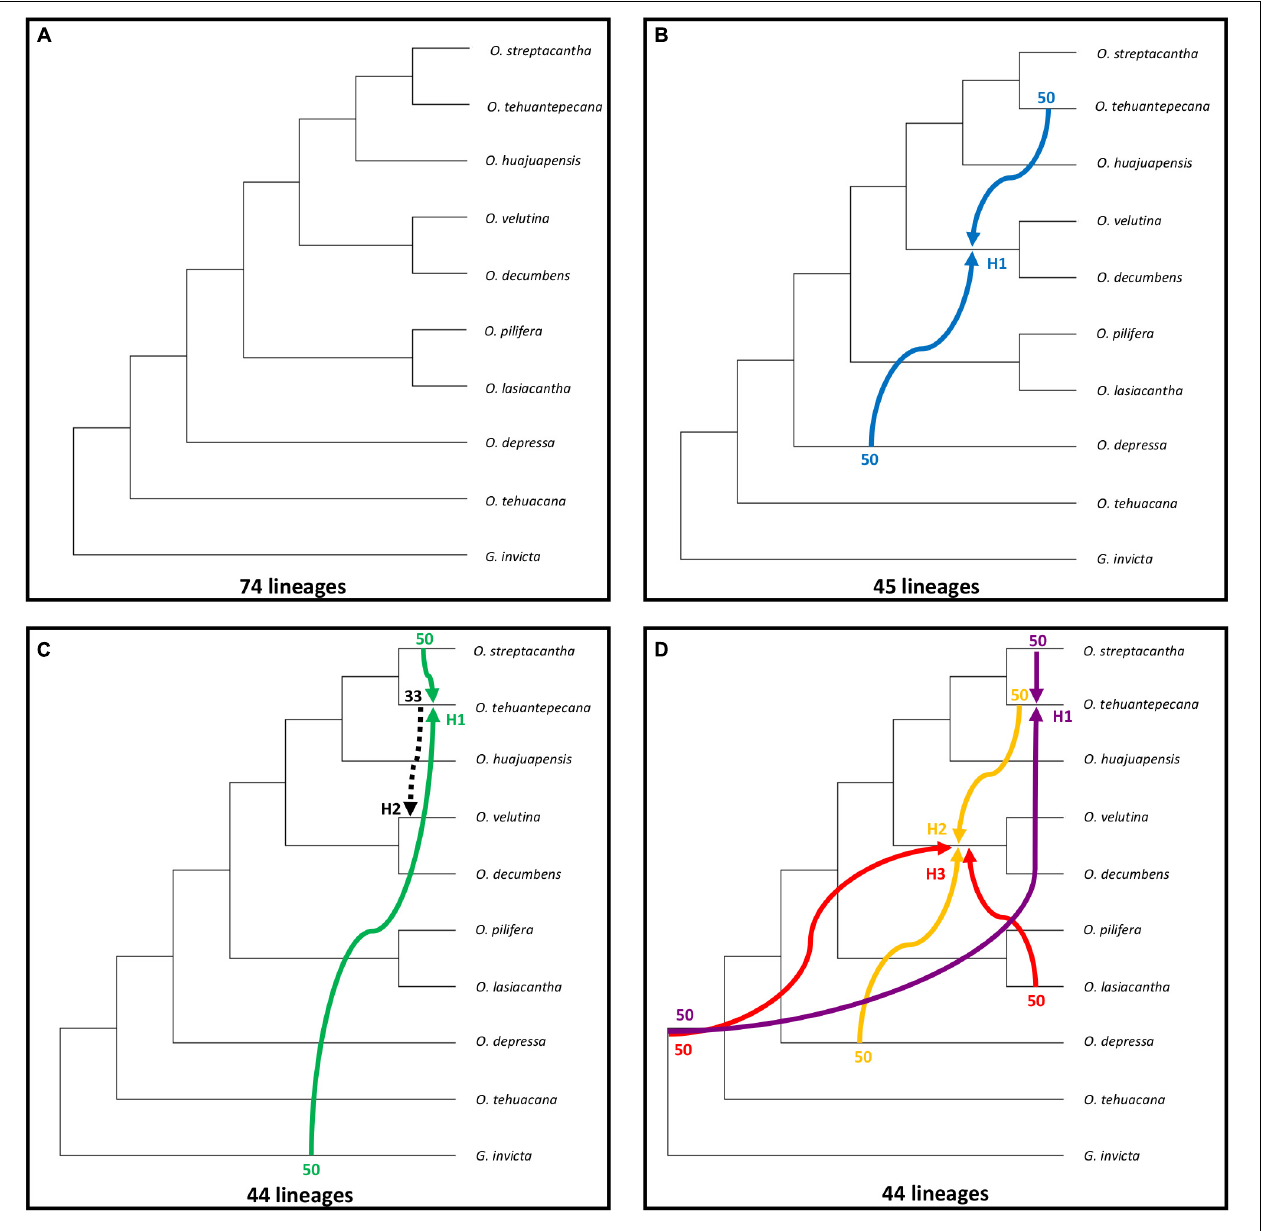
FIGURE 4 | MDC analysis for all sampled Opuntia species. (A) Species tree without reticulations. (B–D) Best reticulation inference from one to three possible reticulations, number of reticulations indicated with H1, H2, H3. Inheritance probabilities are indicated before each arrow. Hybridization events are indicated with solid colored arrows, and the dashed arrow indicates an introgression